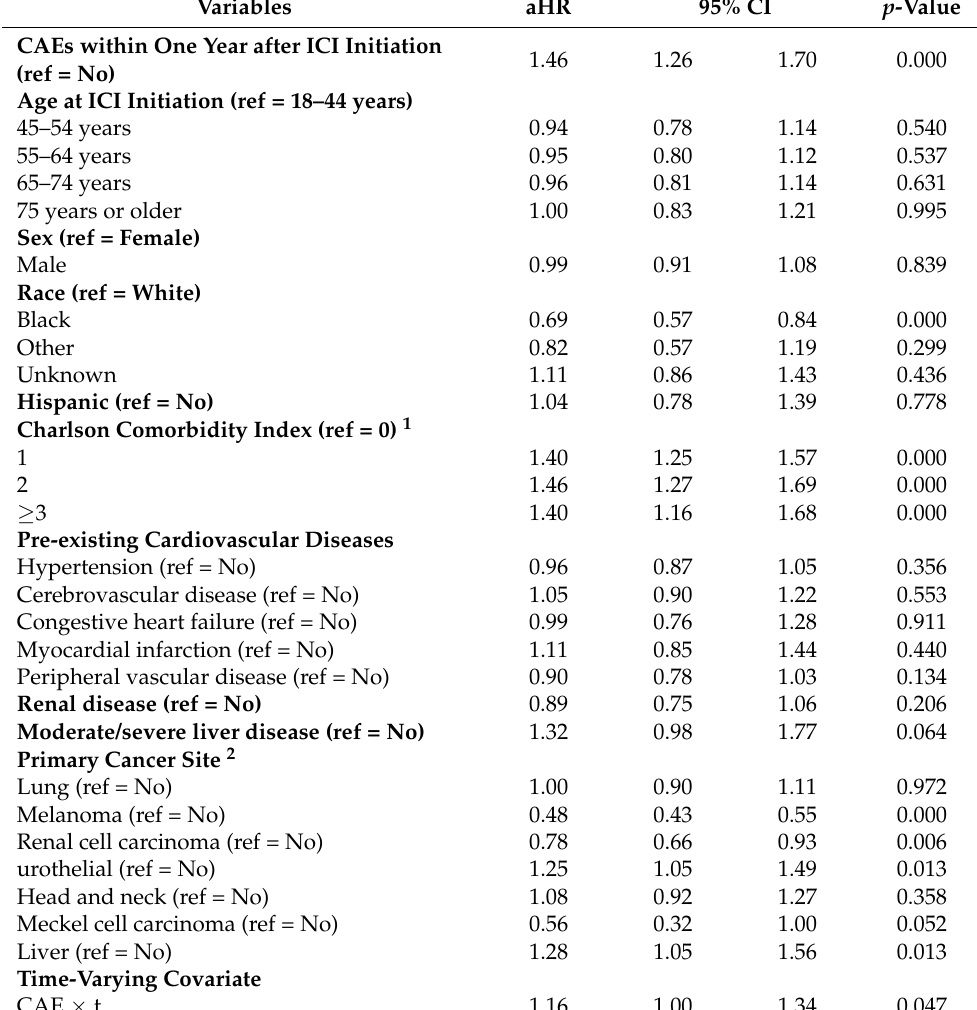
Table 4. Hazard ratios for overall survival.